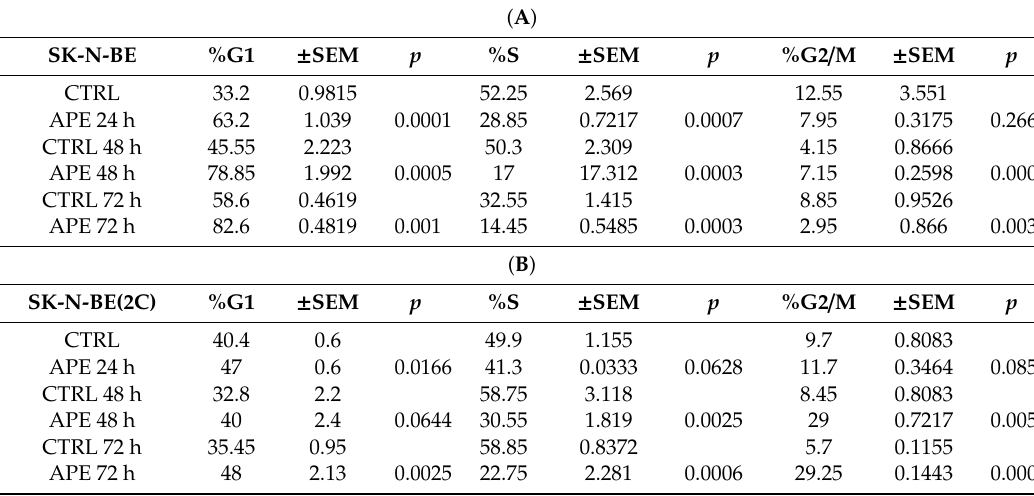
Figure 4. Representative RT-PCR and Western blot showing the p53 transcript ( A ) and protein ( B ) expression in SK-N-BE and SK-N-BE(2C) cells. For RT-PCR, 18S was used as a housekeeping gene;